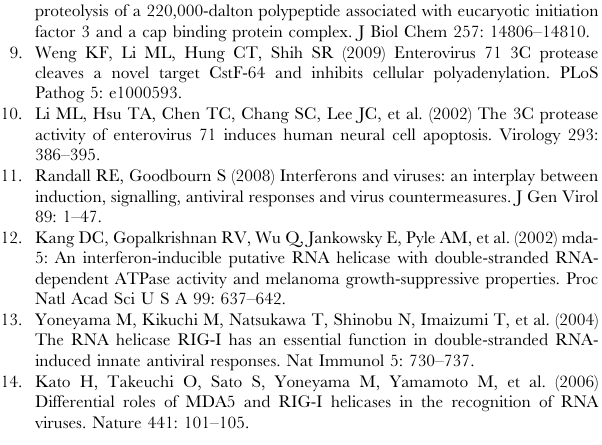
12 h post-infection. The cell extracts were assayed by immuno- blotting using anti-MDA5, anti-PARP, anti-V71 3C, and anti- b - actin antibodies (A). Relative amount of IFN- b mRNA in the cells was measured by real-time RT-PCR (B). Figure S7 In vitro-transcribed EV71 viral RNA stimu- lates IFN- b mRNA production. A plasmid which contains full- length cDNA of EV71/4643 strain in pCR-XL-TOPO vector (kindly provided by Dr. Jen-Ren Wang) was digested with M lu I. EV71 viral RNA was transcribed from the linearized plasmid by MEGAscript in vitro transcription kit (Ambion, USA) with T7 polymerase. The synthesized RNA was purified by RNeasy mini kit (Qiagen, Germany) and treated with FastAP alkaline phosphtase (Fermentas, USA) for 30 min at 37 u C to remove 5 9 - triphosphates. After inactivating the enzyme activity at 75 u C for 5 min, the dephosphorylated RNA was extracted by phenol- chloroform and precipitated by isopropanol. For the preparation of control RNA, a pcDNA3 empty plasmid was linearized by NotI and performed the in vitro transcription and RNA purification, as described above. HeLa cells were transfected with 2 m g of control or dephosphorylated in vitro-transcribed EV71 RNA. At 24 h post-transfection, total RNA was isolated and analyzed by real- time PCR for measuring relative amount of IFN- b mRNA expression. IVT, in vitro transcription. Figure S8 Total IRF3 expression is reduced during EV71 infection. HeLa cells were infected with the MP4 strain of the EV71 virus. At 4 h post-infection, the cells were transfected with 2 m g of poly(I:C) or transfection reagent alone. At 16 h post- transfection, cell extracts were analyzed by immunoblotting using anti-phospho-IRF3, anti-total IRF3, anti-EV71 3C, and anti- b - actin antibodies.